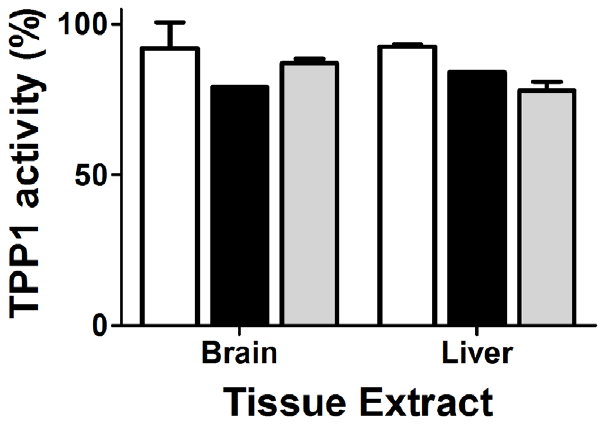
extracts. Activated TPP1 was mixed with either brain or liver extracts (20 and 10 mg tissue wet weight/mL, respectively) from Tpp1 ( 2 / 2 ) mice (final concentration 0.06 mg/mL TPP1, 90% tissue extracts in 150 mM sodium chloride, 100 mM sodium acetate pH 4.5, 0.1% Triton X-100), incubated at 37 u C and frozen at the times indicated in Fig. 3 prior to measurement of TPP1 activity. Given that activity was relatively unchanged throughout the incubation, only the 24 h time point is shown. Unmodified TPP1, open bars; OX-TPP1, filled bars, DG-TPP1, gray bars. Error bars represent standard deviation from duplicate measurements.